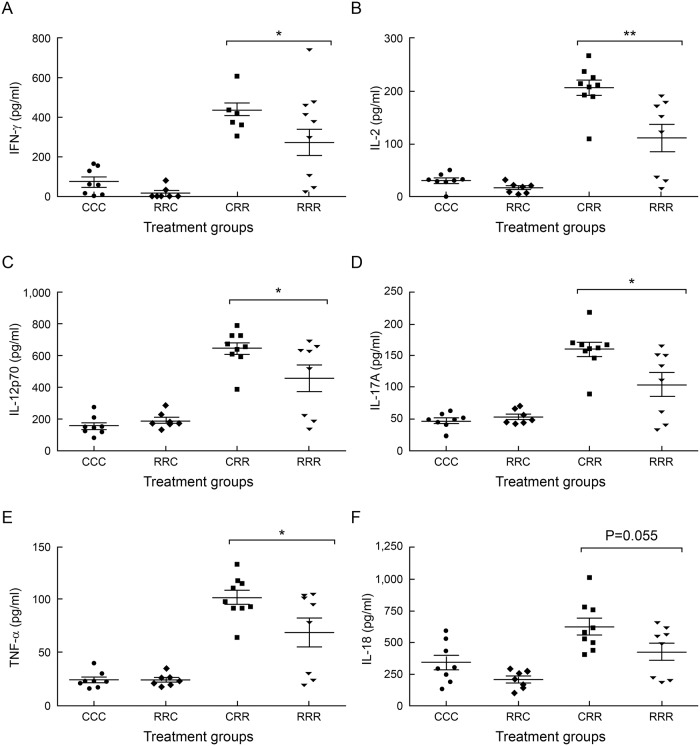
Maternal rrRSV infection is associated with altered immunity in offspring with recurrent postnatal rrRSV LRTI.Serum harvested from 28-day old weanling rats at the peak of rrRSV LRTI was analyzed using a multiplex cytokine/chemokine ELISA. Results demonstrate that maternal rrRSV infection reduces: (A) IFN-γ, (B) IL-2, (C) IL-12p70, (D) IL-17A, (E) TNF-α, and (F) IL-18 in offspring with recurrent early-life rrRSV LRTI (RRR) compared to controls from mothers not exposed to RSV (CRR). Data for 3 experiments were combined and expressed as the mean ± SEM of ≥7 rats per group. Two-tailed student’s t test: *P<0.05, **P<0.01 compared to RRR group.